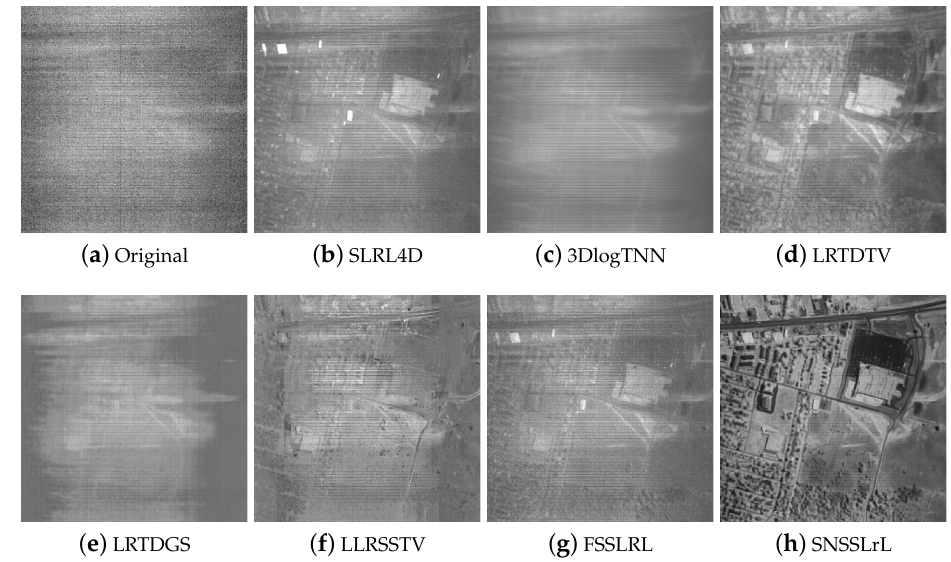
Figure 10. Real comparison of all methods on bands 144 of Urban dataset.